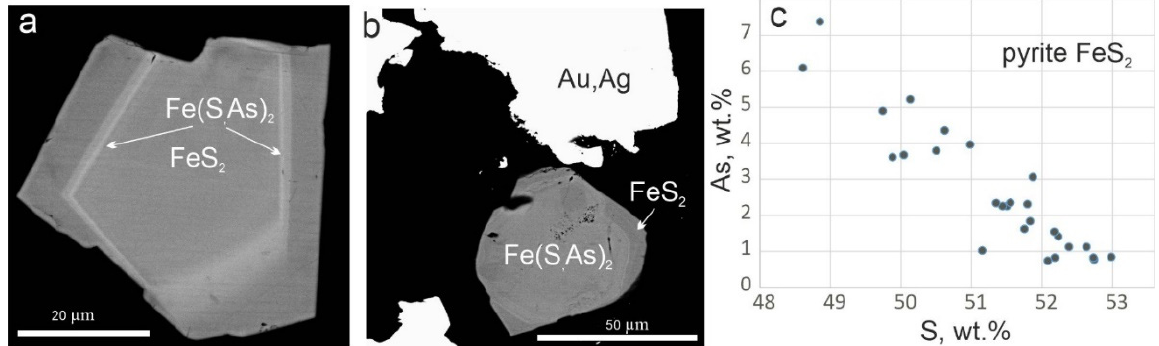
Figure 5. Back-scattering electron mode (BSE)–scanning electron microscope (SEM) images of As-containing pyrite grains ( a , b ) and the negative correlation S versus As in pyrite of Baranyevskoe deposit ( c ). Table 1. Composition of the main sulfides of the Baranyevskoe deposit, wt. Two hundred grains of gold from different zones and areas of the Baranyevskoe deposit were analyzed. The complete Au-Ag solid solution are subdivided, according to [30] into native gold—up to 30 atomic (at.) % of Ag (fineness 1000–700 ‱ ), electrum (fineness 700–300 ‱ ), “küstelite” (mineral not approved by International Mineralogical